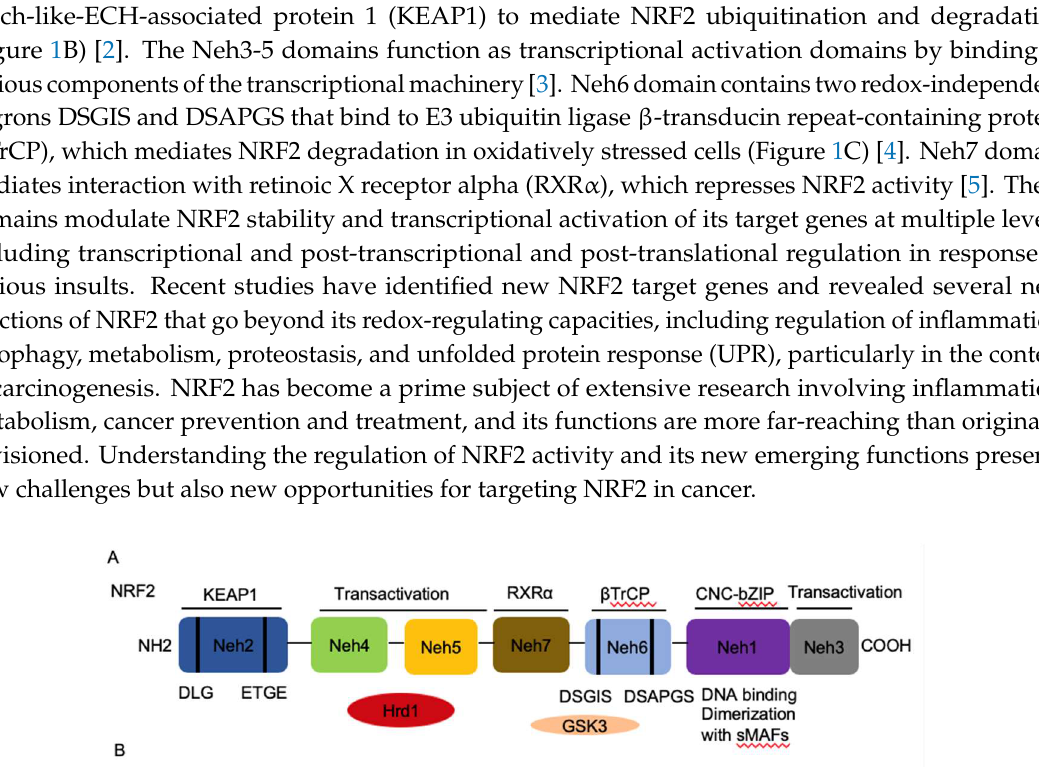
Kelch-like-ECH-associated protein 1 (KEAP1) to mediate NRF2 ubiquitination and degradation (Figure 1B) [2]. The Neh3-5 domains function as transcriptional activation domains by binding to various components of the transcriptional machinery [3]. Neh6 domain contains two redox-independent degrons DSGIS and DSAPGS that bind to E3 ubiquitin ligase β -transducin repeat-containing protein ( β TrCP), which mediates NRF2 degradation in oxidatively stressed cells (Figure 1C) [4]. Neh7 domain mediates interaction with retinoic X receptor alpha (RXR α ), which represses NRF2 activity [5]. These